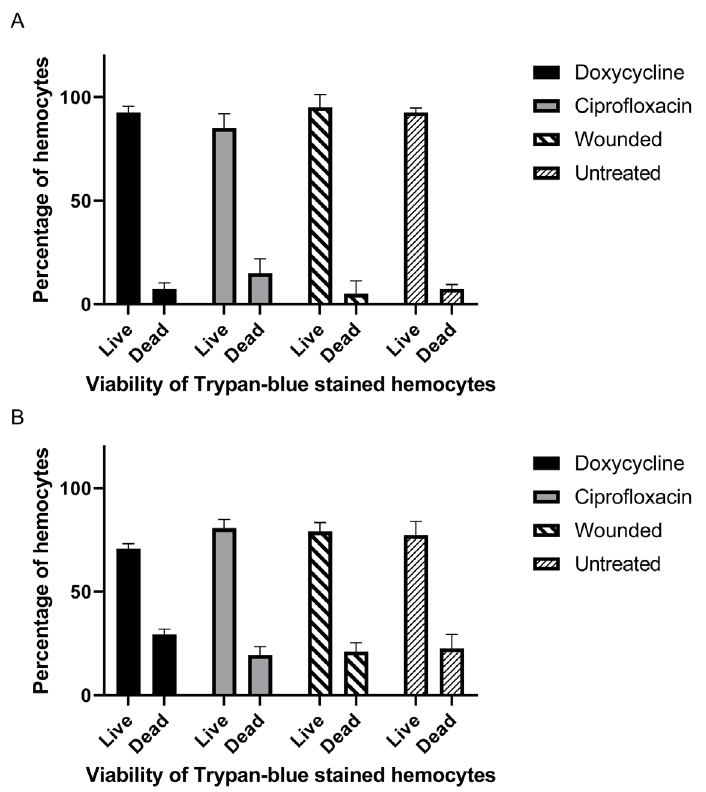
Figure 6. Viability of ex vivo hemocytes incubated at 37°C at T0 ( A ) and T7 ( B ). Average across 3 replicate wells per treatment, derived from the pooled hemolymph from 10 larvae and seeded at 2 x 10 5 cells/ml. Hemocytes were dissociated with trypsin and stained with trypan blue. Error bars = SD. Mean percentage (and SD) of hemocytes live at T0: doxycycline treated 93% (±3); ciprofloxacin treated, 85% (±6.9); wounded, 95% (±6.2); untreated, 93% (±2.1). Mean percentage (and SD) of hemocytes live at T7: doxycycline treated 71% (±2.5); ciprofloxacin treated, 81% (±4.2); wounded, 79% (±4.4); untreated, 77% (±6.7).